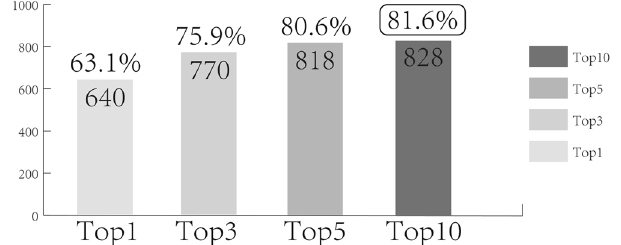
Figure 2. Evaluation of database accuracy based on search results. Different histograms represented top-n genes with the highest combined score of a specific drug used for evaluation; the number in the histogram represented the number of drugs whose top-n genes were related to the indication; percentage represented the ratio of the number in the histogram to the amount of drugs used for evaluation. X axis: top-n genes that were used for evaluation; Y axis: number of the drugs whose related genes were related to the indication of the drug.